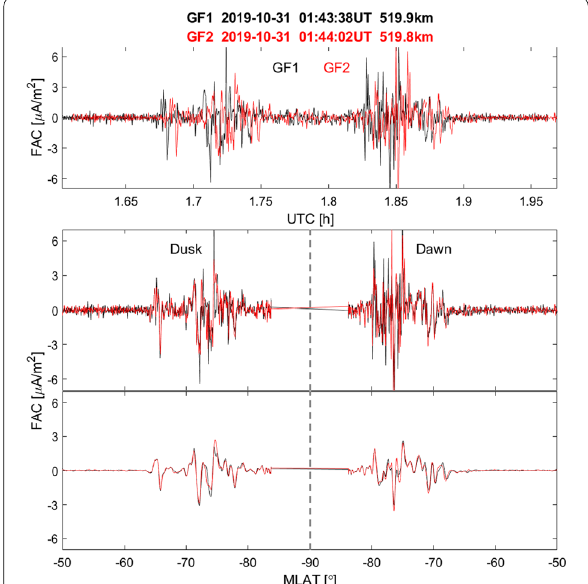
Fig. 2 Profile of FACs derived from GF1 (black) and GF2 (red) for an event on 31 October 2019 when the mission crossed the southern auroral latitudes. The upper panel shows the time series, while the lower two panels show the variations over MLAT, of (middle) the original 1-Hz resolution and (bottom) low-pass filtered (cutoff period of 20 s)